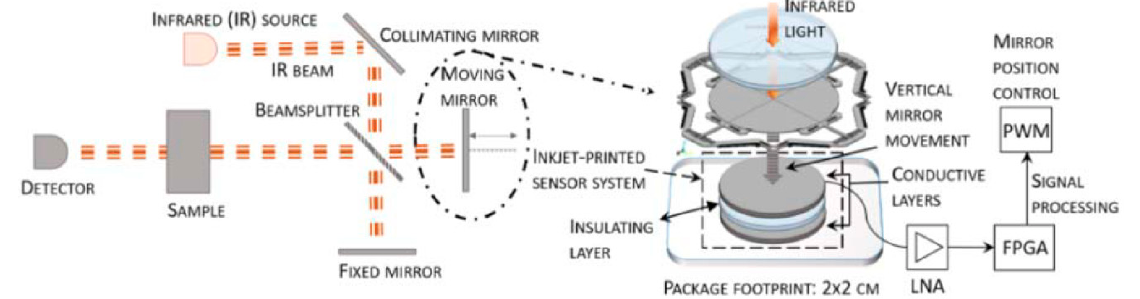
Figure 1. Spectrometer and sensor system